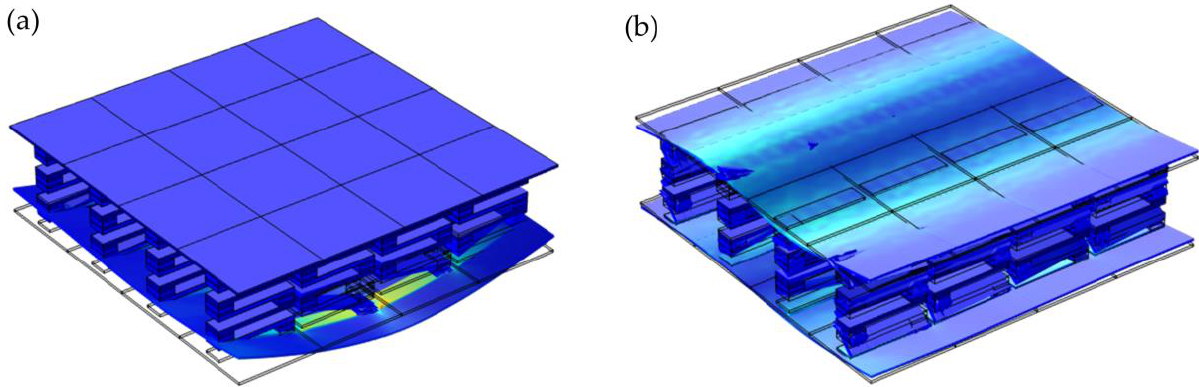
Figure 9. Vibration modes of finite phononic crystal plates with frequencies in different ranges. ( a ) The frequency range of attenuation ( f = 80 Hz). ( b ) The range of frequencies that are not decaying ( f = 126 Hz).